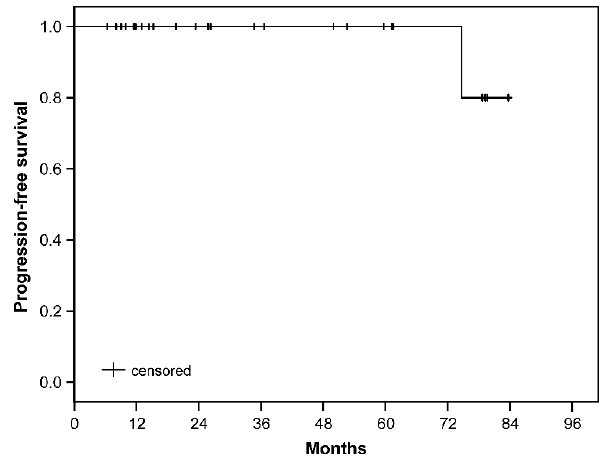
Figure 3. Kaplan–Meier curve of the progression-free survival. Patients at risk after 6-, 12-, 24-, 36-, and 72 months after SRS were 27, 19, 13, 11, and 4, respectively.